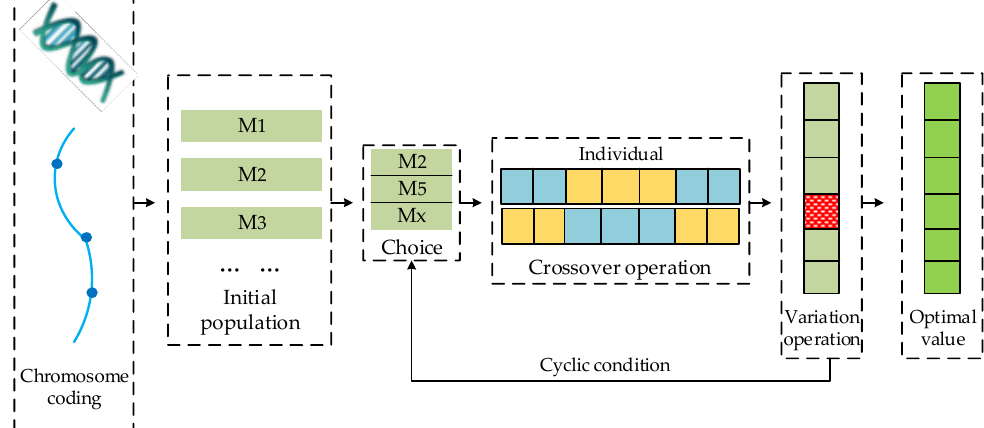
Figure 2. Platform scheduling model: ( a ) task scheduling model; ( b ) processing system model.